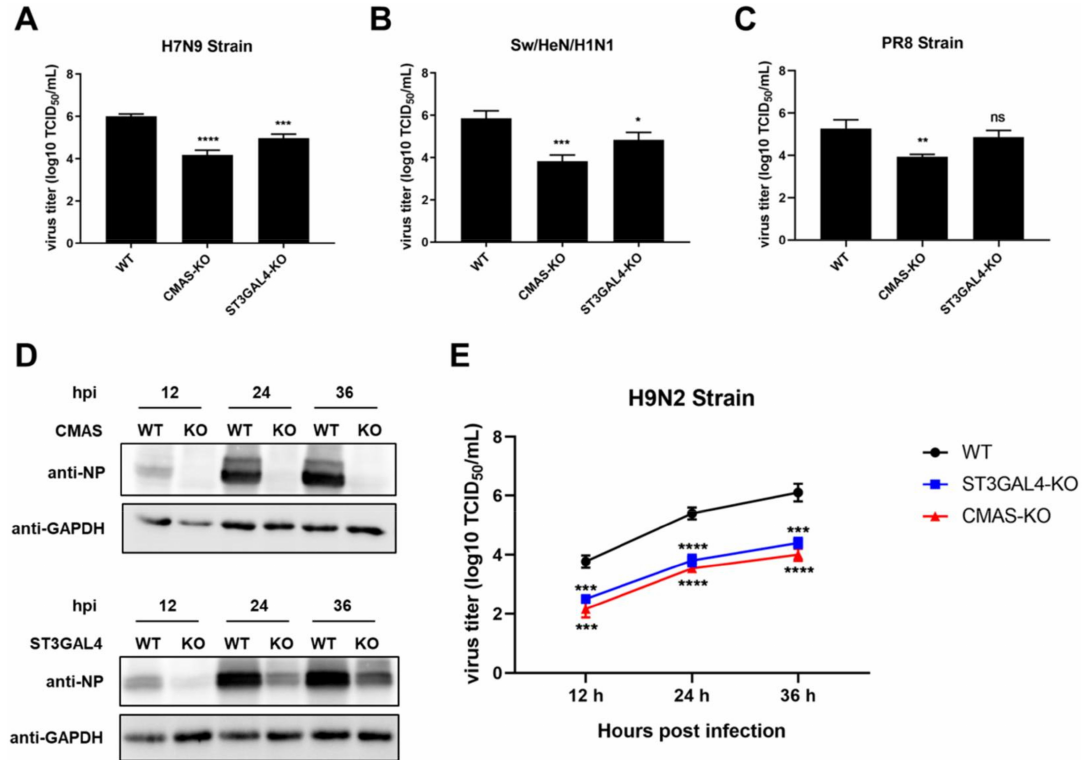
Figure 4. Effects of KO cell lines on the proliferation of influenza viruses of different species. CMAS -KO and ST3GAL4 -KO NPTr cells were generated through the CRISPR/Cas9 system; NPTR-Cas9 cells were used as wild-type control. ( A – C ) Effects of KO cell lines on the proliferation of influenza viruses of different species at 36 hpi. WT NPTr cells and KO NPTr cells were infected with ( A ) H7N9 virus, ( B ) Sw/HeN/H1N1 virus or ( C ) PR8 virus (MOI = 0.01). Cell supernatants were collected at 36 hpi, and virus titers were determined by TCID 50 assay on MDCK cells. (Data from three independent experiments, mean ± SD; * p < 0.05; ** p < 0.01; *** p < 0.001; one-way ANOVA). ( D , E ) Effects of KO cell lines on the proliferation of H9N2 influenza viruses. WT NPTr cells and KO NPTr cells were infected with the H9N2 virus (MOI = 0.01). Cell supernatants and lysates were collected at 12, 24, and 36 hpi. ( D ) Viral protein expressions were detected by Western blotting or ( E ) virus titers were determined by TCID 50 assay on MDCK cells. (Data from three independent experiments, mean ± SD; * p < 0.05; ** p < 0.01; *** p < 0.001; **** p < 0.0001; ns represented no significance; one-way